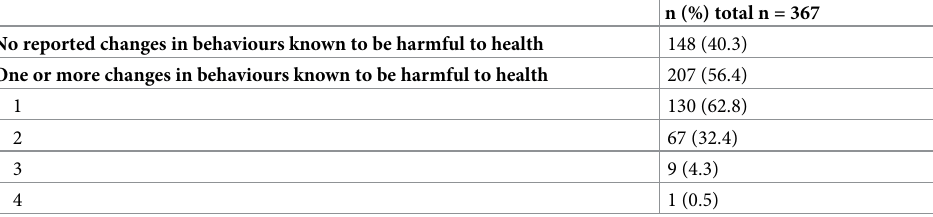
Table 3. Cumulative index of self-reported behaviours harmful to health for the OWLS COVID-19 study